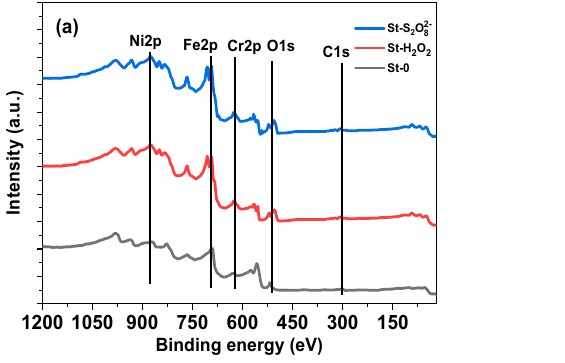
Figure 4. ( a ): Survey XPS spectra of stainless steel (St-0), stainless steel immersed in hydrogen peroxide (St-H 2 O 2 ), and stainless steel immersed in potassium persulfate (St-S 2 O 82 − ); ( b ): high- resolution XPS Fe2p envelopes. Table 4. Relative surface chemistry of the samples calculated from XPS spectra. Relative Element Concentration Sample